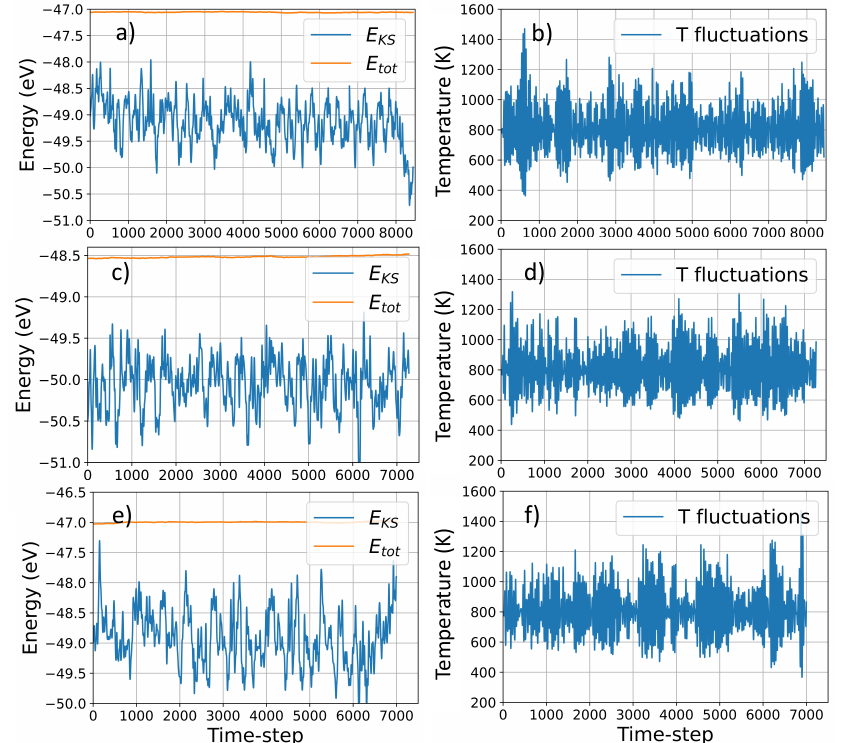
Figure 2. Temperature and energy (potential vs total) fluctuations during VASP MD simulation structure I, II and III, In the figure, E KS and E tot indicate the electronic energy and total energy, respectively, whereas T fluctuations indicate the temperature fluctuations during the simulations due to the Nosé thermostat coupling. Panel ( a ) and ( b ), ( c ) and ( d ), and ( e ) and ( f ) correspond to structure I, II and III, respectively.